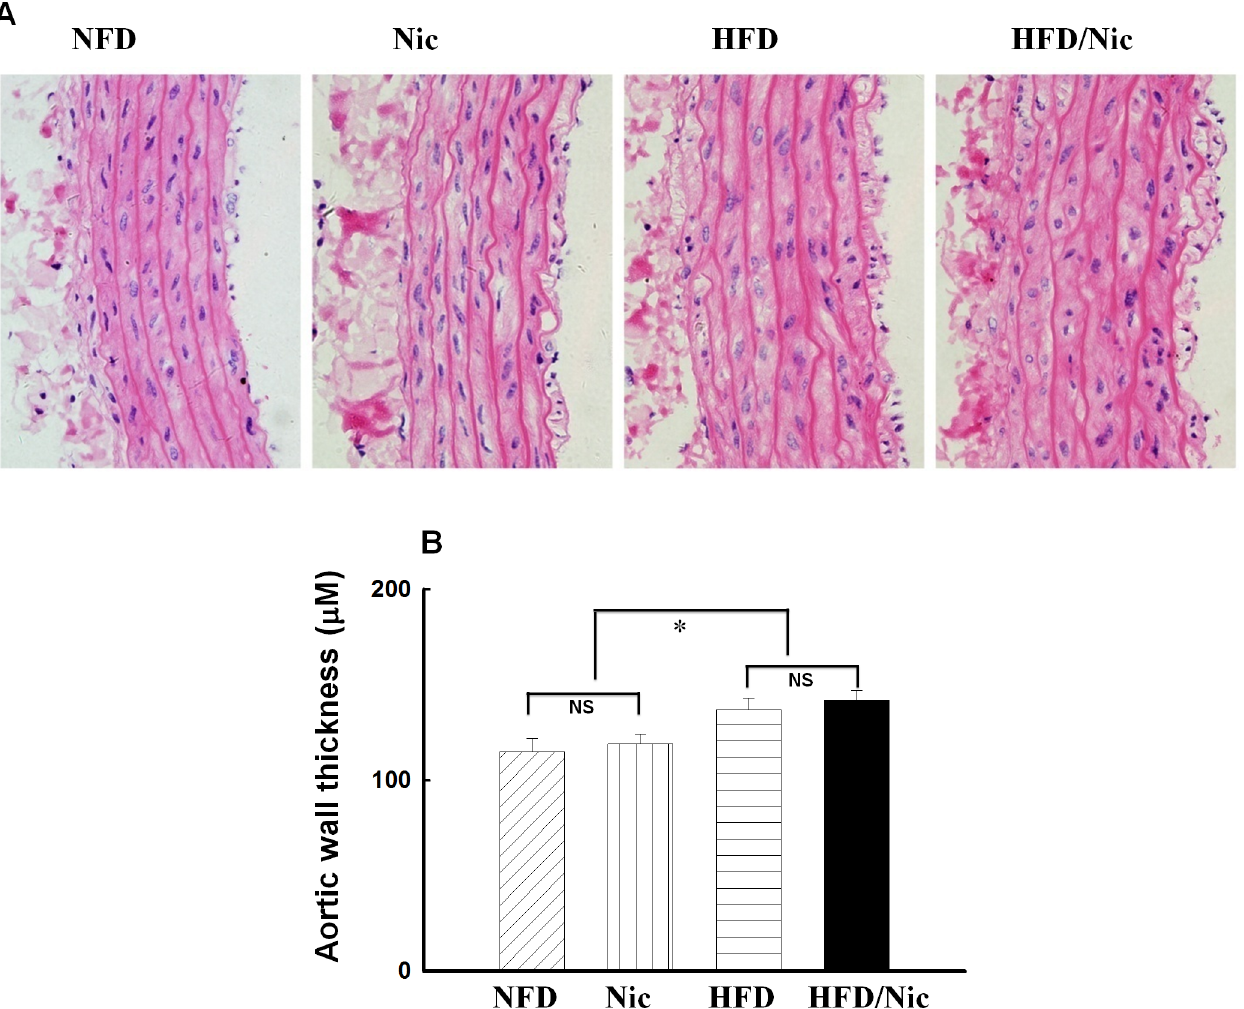
Fig 2. Histological examination of aortic hypertrophy in nicotine treated obese rats. Representative cross section of aortic wall (A) stained with HE. Bar graphs show the quantitative analysisof aortic wall thickness (B). * p < 0.05 vs. NFD, N = 6–7.